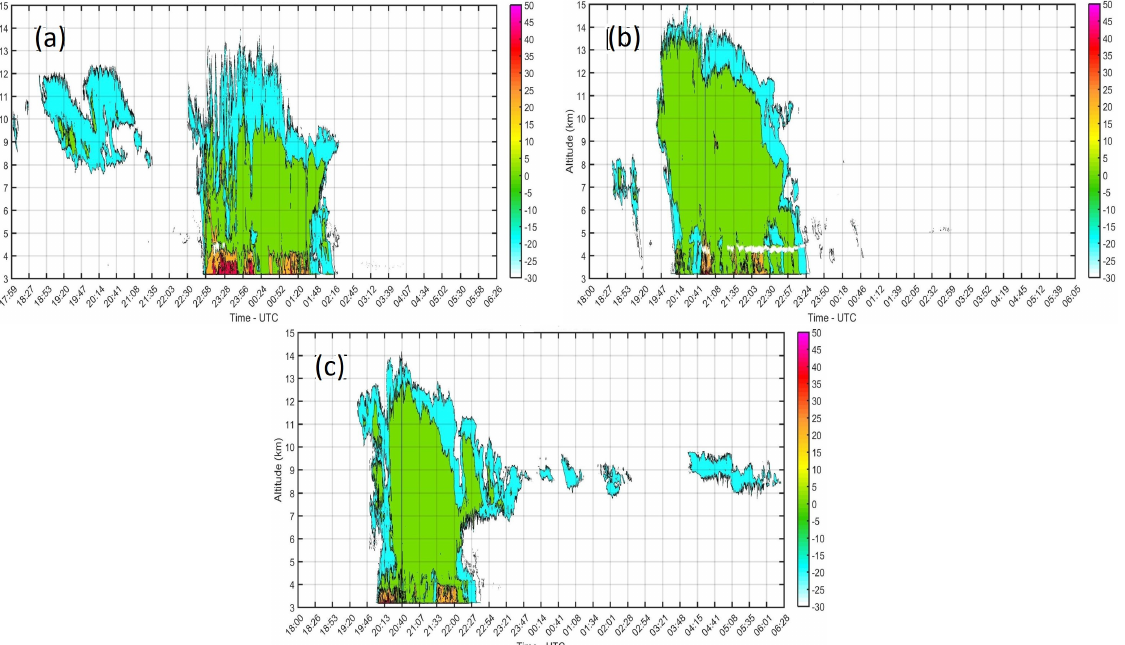
Figure 6. Time series (UTC-5) of reflectivity (dBZ) obtained from the Magnetron based cloud radar MIRA-35C above the Huancayo observatory for ( a ) TS1; ( b ) TS2 and ( c ) TS3